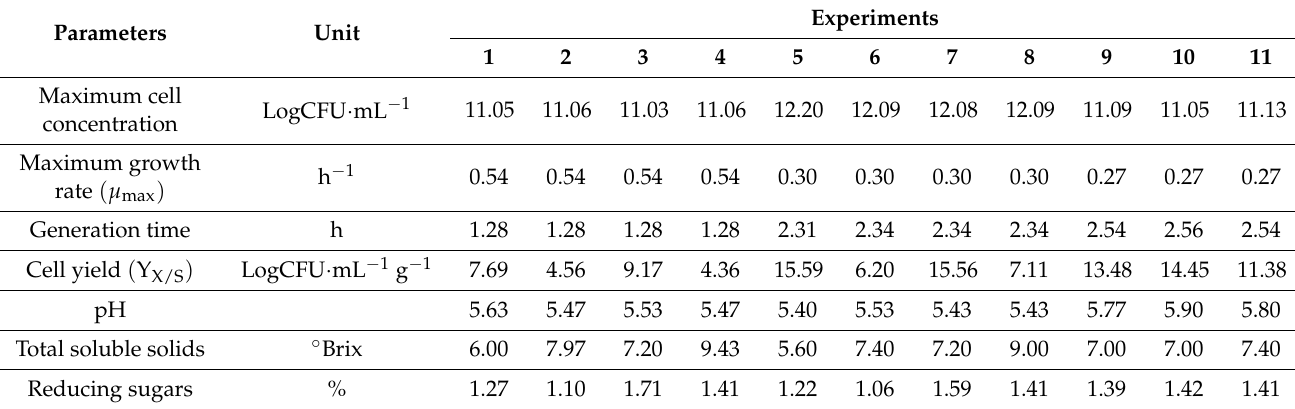
Table 2. Biological and physicochemical characteristics of the filmogenic solutions fermented with L. salivarius , after 4 h of